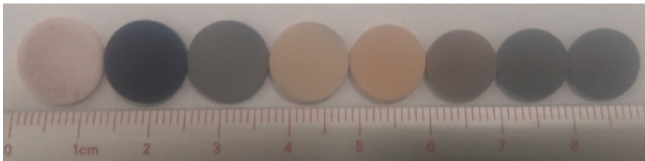
Figure 4. Photograph of green and sintered MnHA pellets. From left to right: green MnHA followed by MnHA heat-treated at 700–1300 °C at 100 °C increments. The pellet size also decreases from left to right.